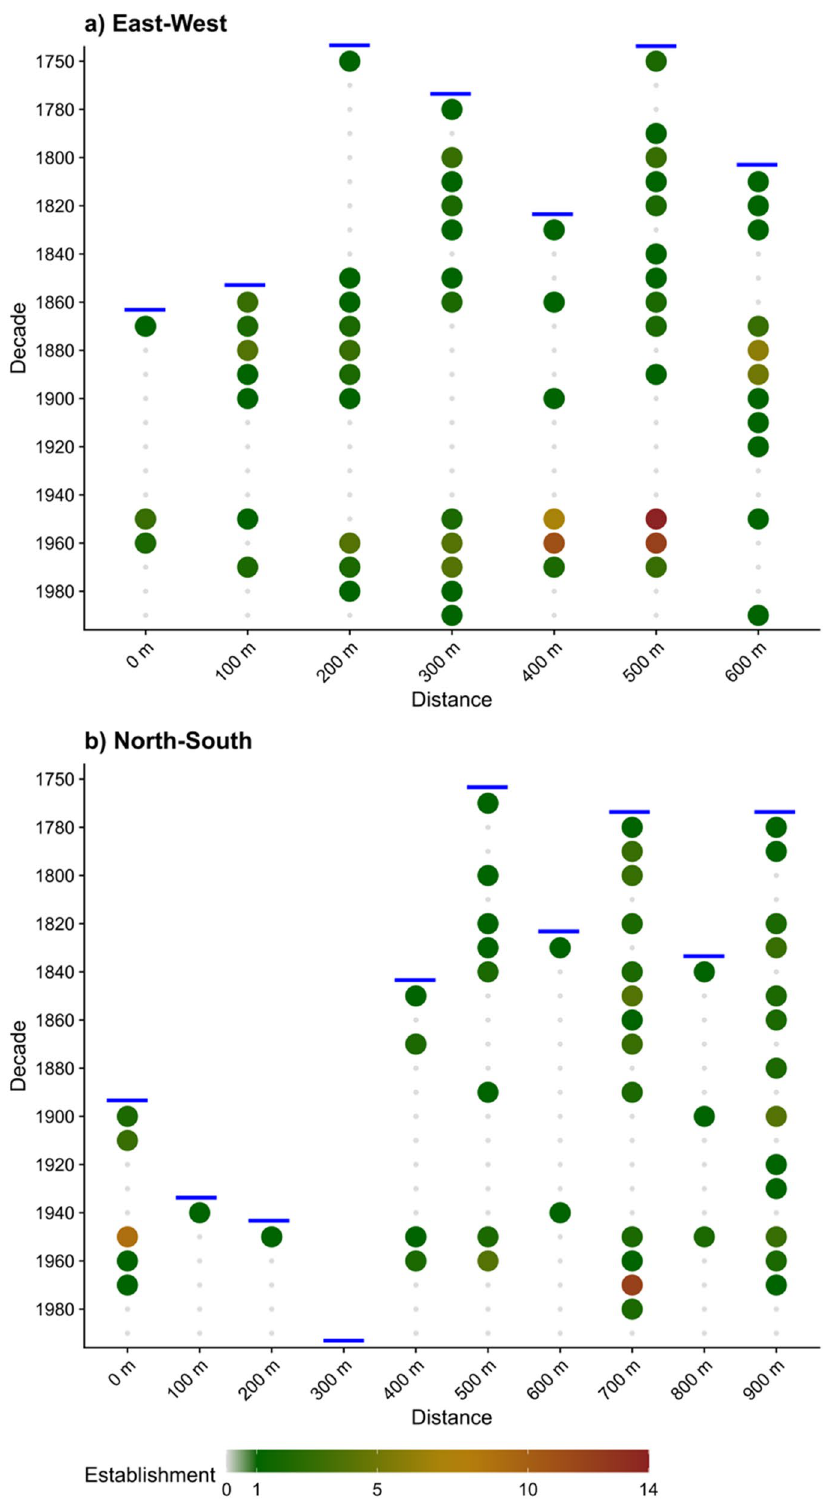
Figure 7. Establishment dates determined by dendrochronological analysis of sampled Callitris intratropica trees on two transects ( a , b , see Fig. 6ab and S4) at Dukaladjarranj Aboriginal estate in central Arnhem Land (Fig. S4). Shading denotes the number of trees that established in each decade. The blue horizontal lines denote the limit of the dendrochronological record for each section on the